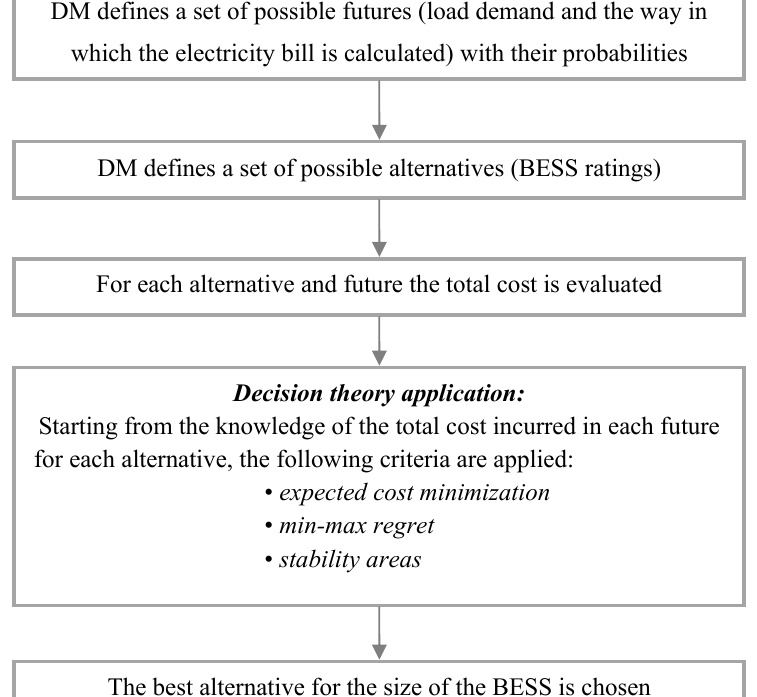
Figure 1. Flowchart of the proposed procedure. DM: decision maker; BESS: battery energy storage